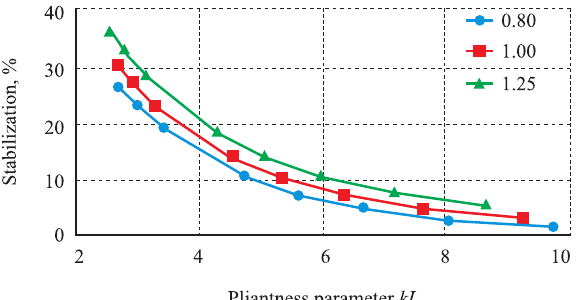
Fig. 4. Stabilization of general displacements, at the middle of the first span, by the bending stiffness